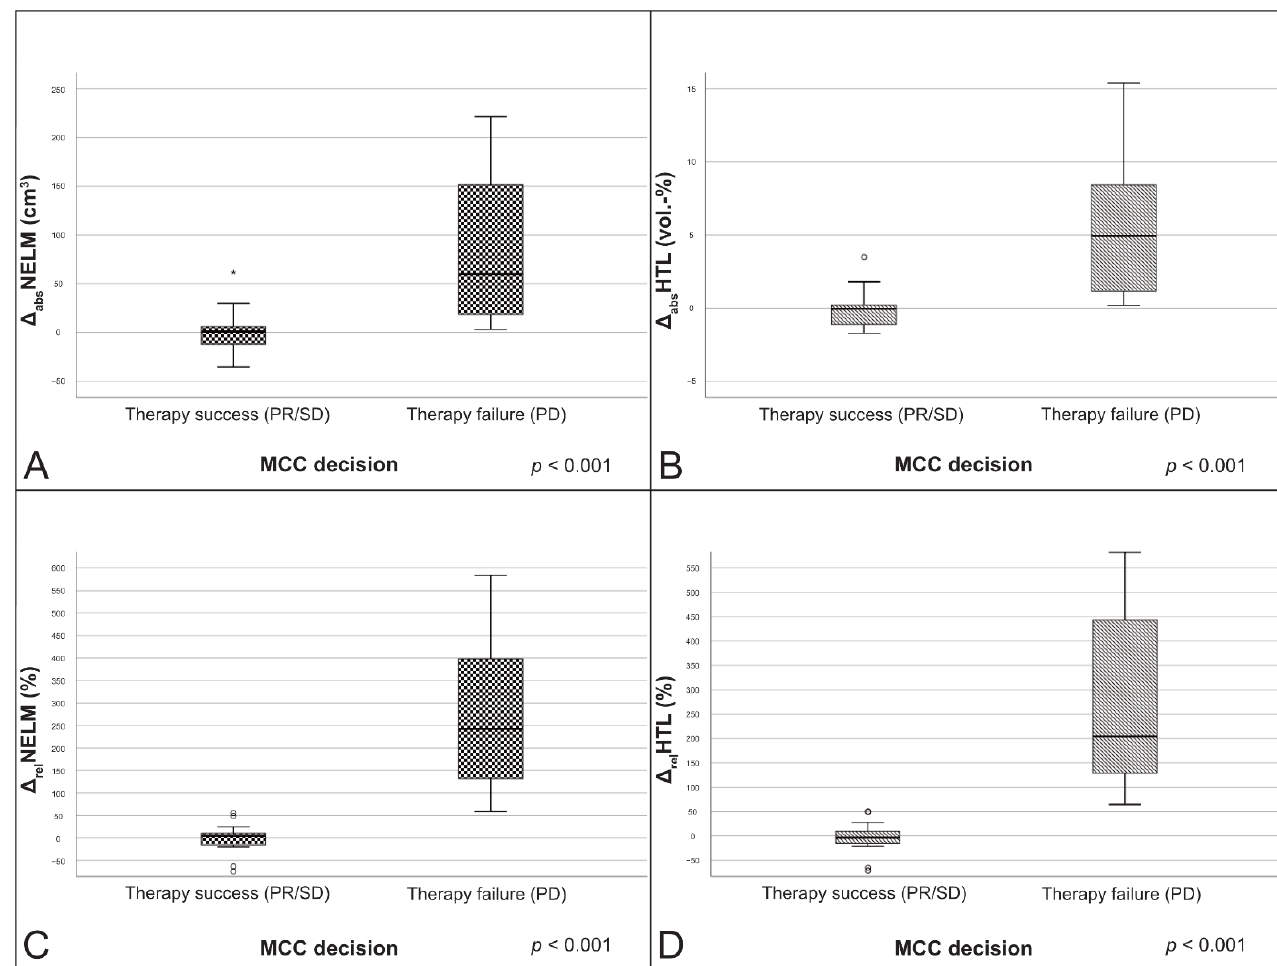
Figure 3. Boxplots of the change variables in correlation to the MCC decisions. ( A ) Δ abs NELM; ( B ) Δ abs HTL; ( C ) Δ rel NELM; ( D ) Δ rel HTL. PR: partial response; Δ abs NELM: absolute NELM volume change; Δ abs HTL: absolute HTL change; Δ rel NELM: relative NELM volume change; Δ rel HTL: relative HTL change.